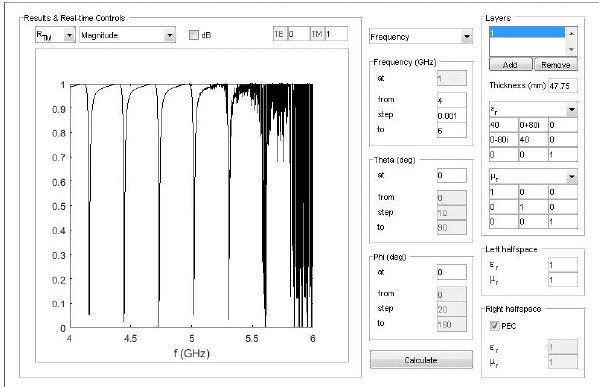
Figure 3: The GUI layout and its response for the first example. This example demonstrates the accuracy of the proposed algorithm for smaller k 0 d values and its unstable response for higher